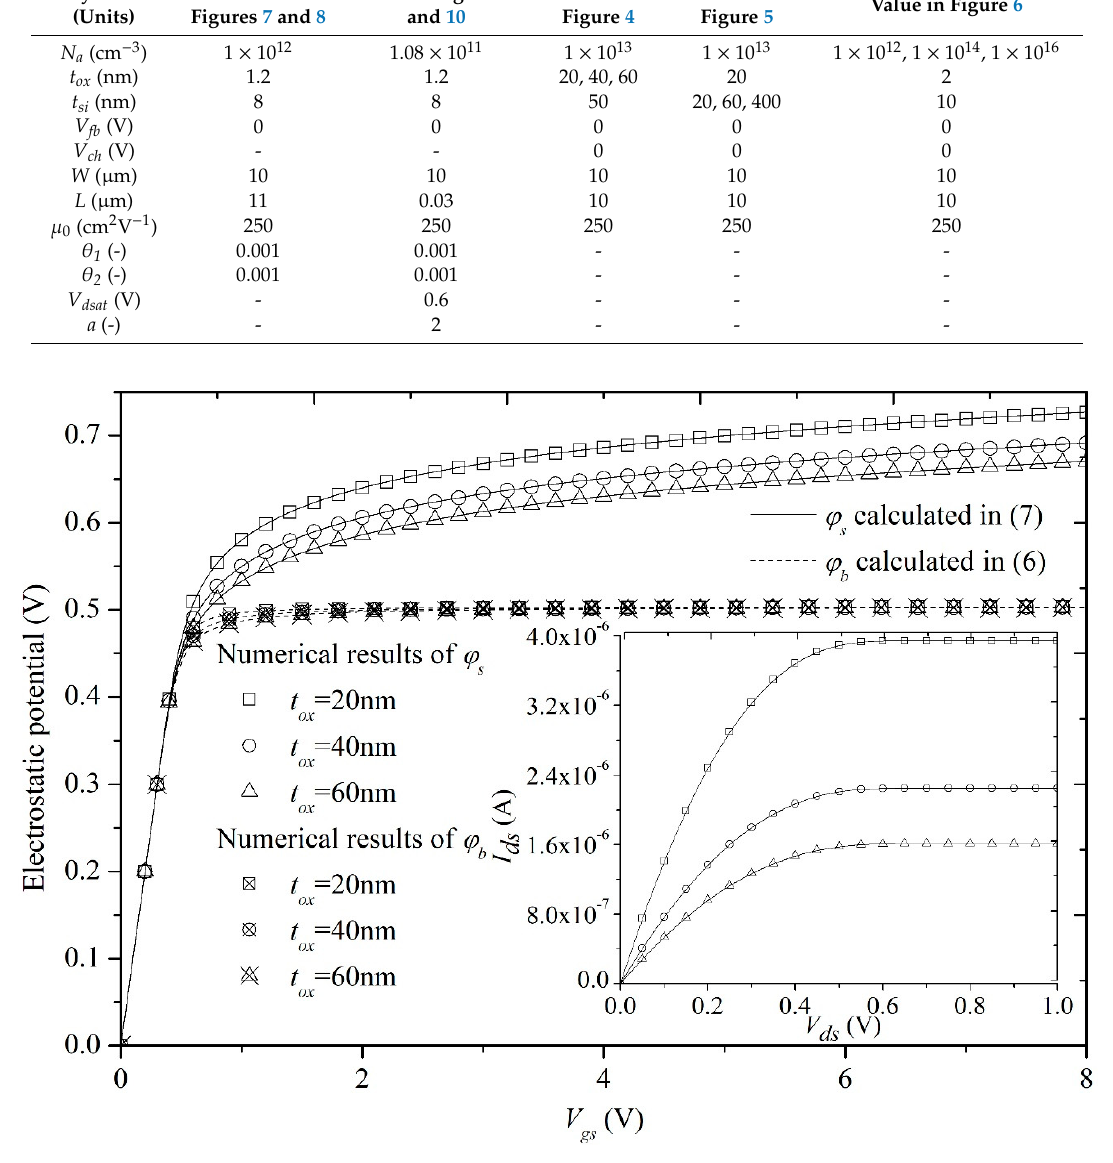
Figure 4. Comparisons between the surface potential calculation scheme and numerical results for different t ox , and the drain current in (11).